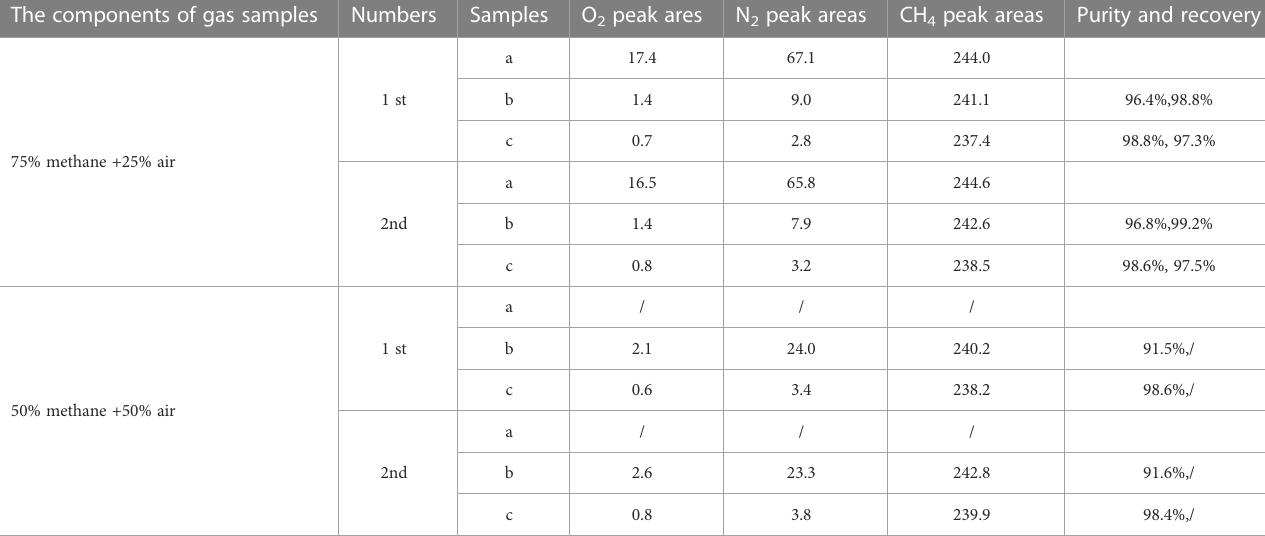
TABLE 5 Puri fi cation results of gases with different air